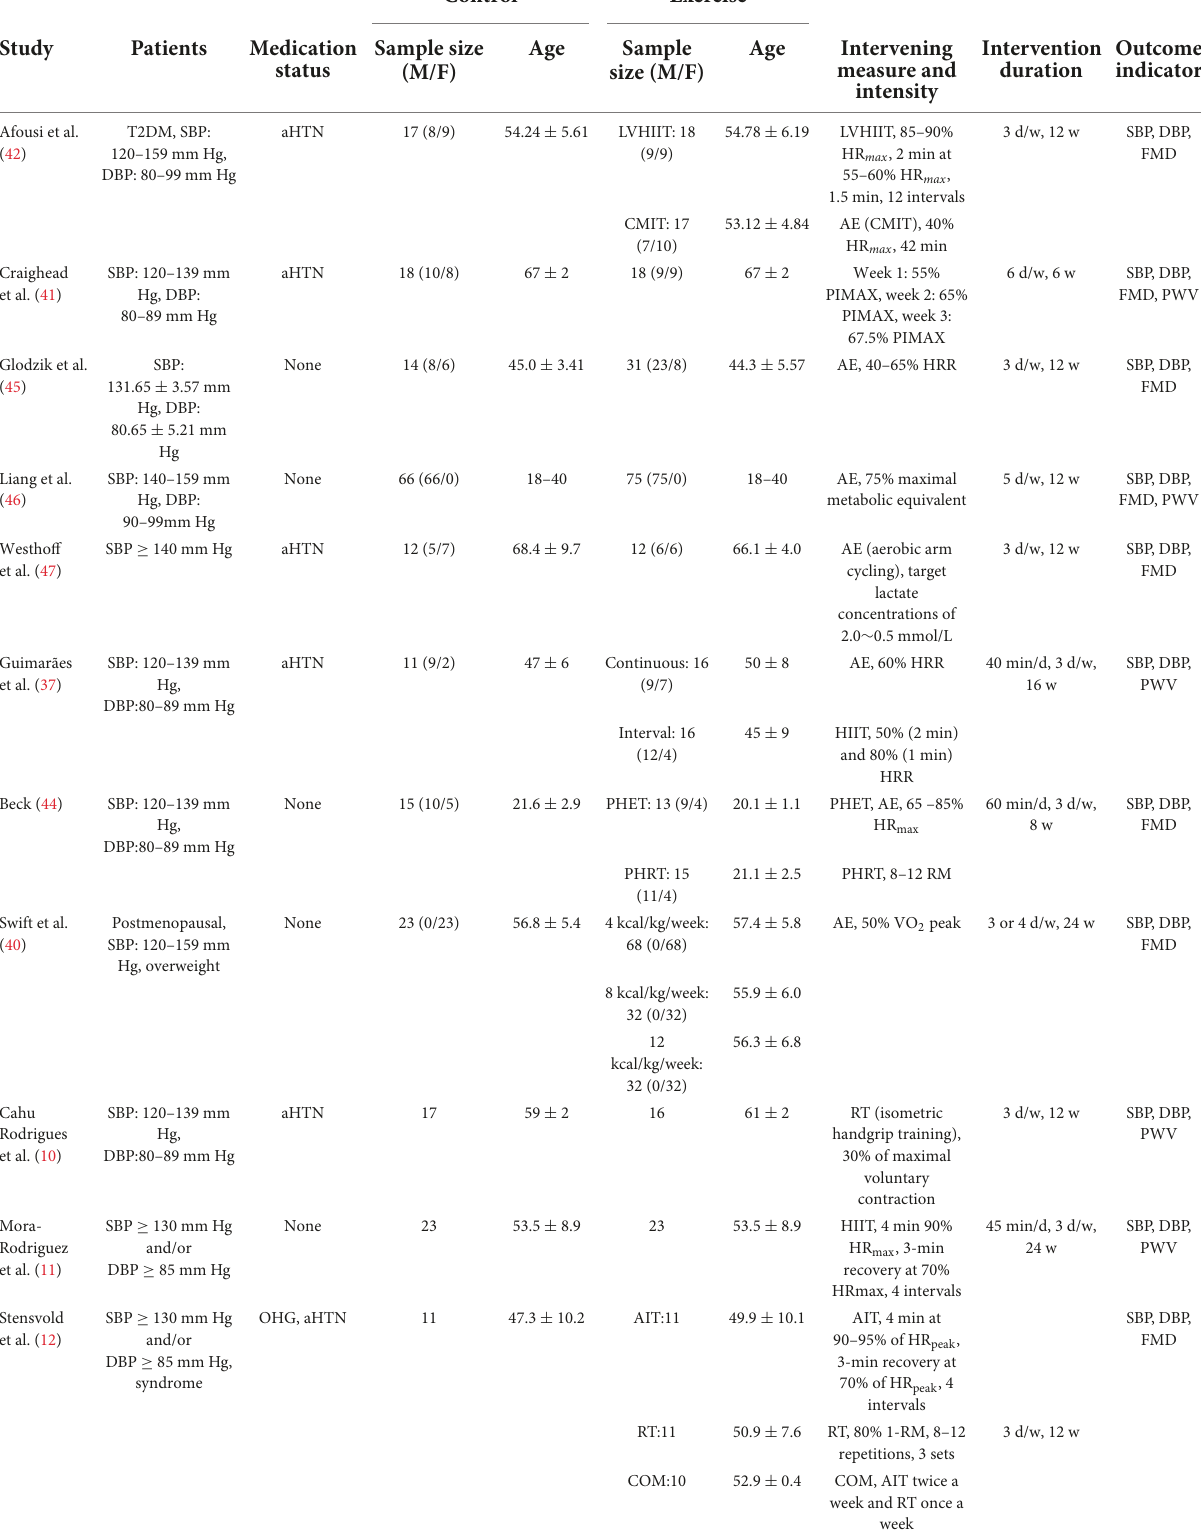
TABLE 1 Characteristics of the included